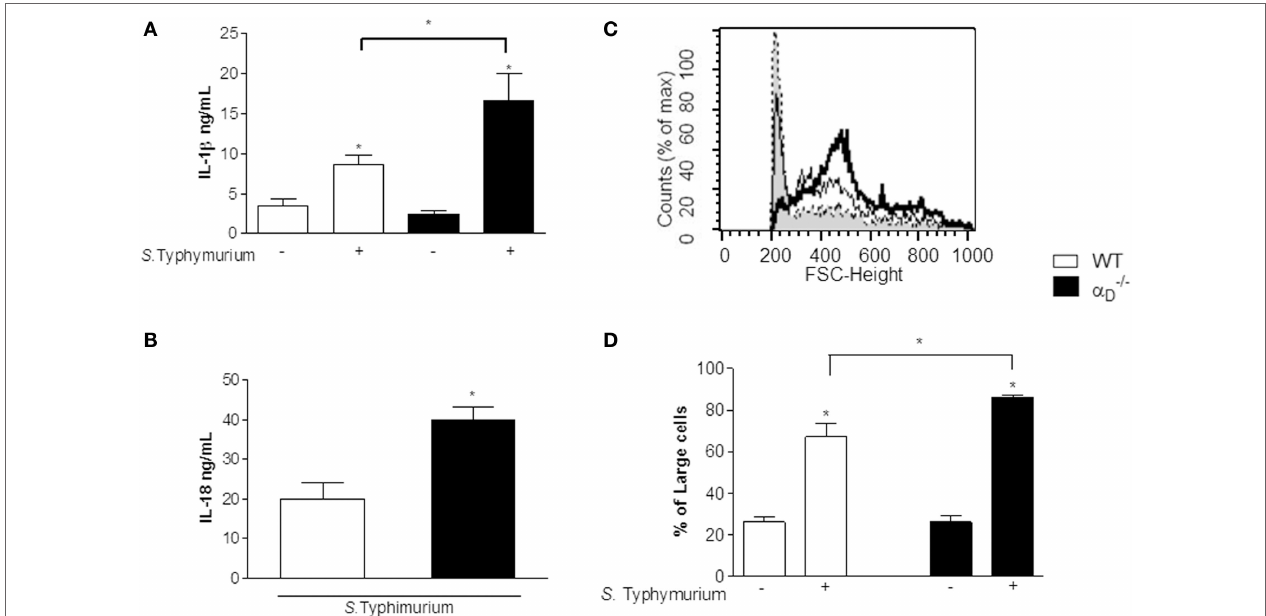
FIGURE 6 | IL-1 β , IL-18, and leukocyte swelling, key markers of pyroptosis, are increased in peritoneal fluid from Salmonella- infected α D β 2 -deficient mice. (A,B) Wild-type (WT) and α –/– D mice were infected with Salmonella Typhimurium (10 5 CFU/animal) or were sham-infected as described in Figure 1 . Peritoneal fluid was collected 72h later, and concentrations of IL-1 β (A) and IL-18 (B) were determined. Significant differences ( p < 0.05) between infected and sham-infected mice are indicated by asterisks and between α –/– D and WT animals by a bar and asterisk. The data in panels (A,B) summarize the results of two experiments performed separately with samples from a minimum of three mice for each condition in each experiment. (C) Histograms indicating the size parameters of cells in peritoneal fluid from WT and α –/– D control and infected animals are shown: dashed line and gray shading, cells from control WT and α –/– D mice; thin black line, WT-infected mice; thick black line, α –/– D -infected mice. The Y -axis indicates cell number, and the X -axis indicates fluorescence intensity (FSC). (D) The fraction of larger cells in samples from control and infected animals of each genotype is shown. Significant differences ( p (cid:20) 0.005) between infected animals and controls are indicated by asterisks and between WT and α –/– D mice by a bar and asterisk. Each bar represents the mean (cid:6) SEM of determinations in samples from (cid:21) 4 animals. The data in this figure are representative of two experiments with similar